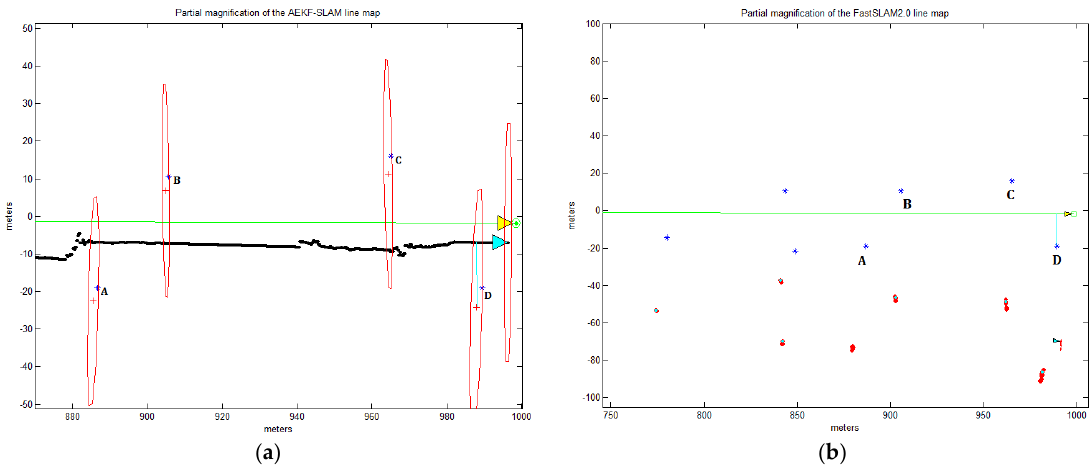
Figure 14. ( a ) Partial magnification of the AEKF-SLAM line map; ( b ) Partial magnification of the FastSLAM 2.0 line map. FastSLAM 2.0 line